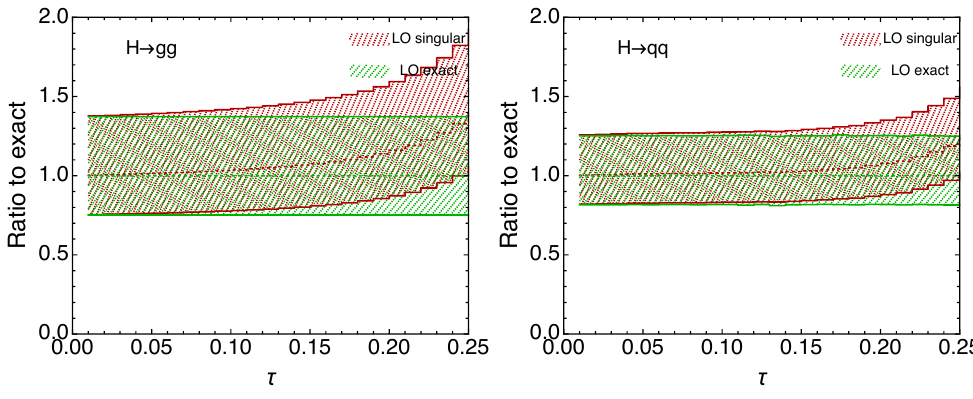
Figure 6 . Comparison between the exact results and the singular terms at